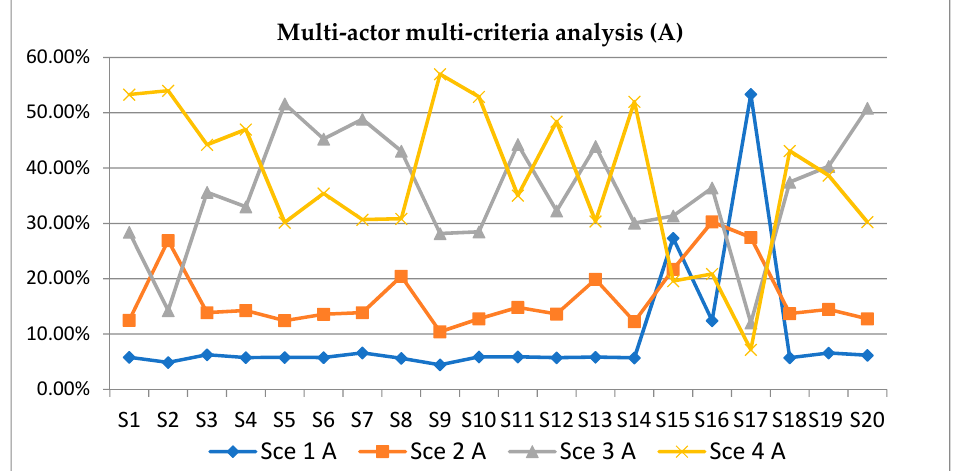
Figure 7. Results of the multi-actor multi-criteria analysis (method A).